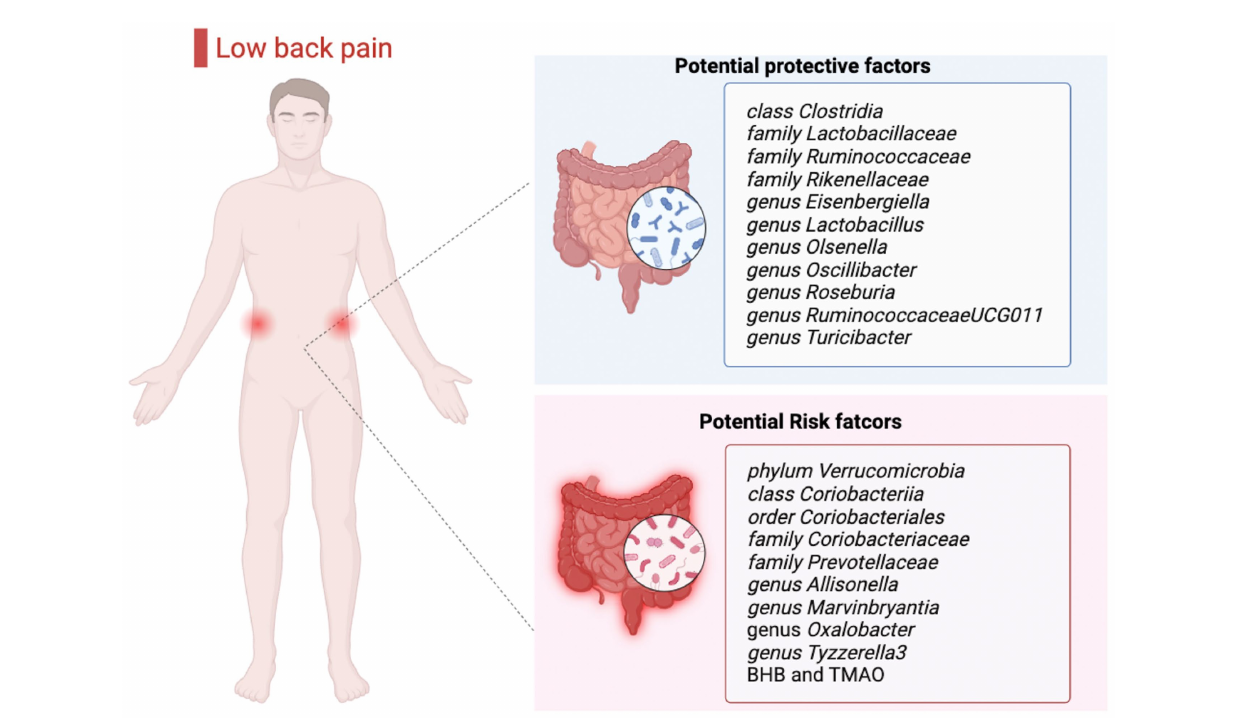
FIGURE 4 Causal links between gut microbiota, gut microbial metabolites and low back pain. BHB, β -hydroxybutyric acid; TMAO, trimethylamine